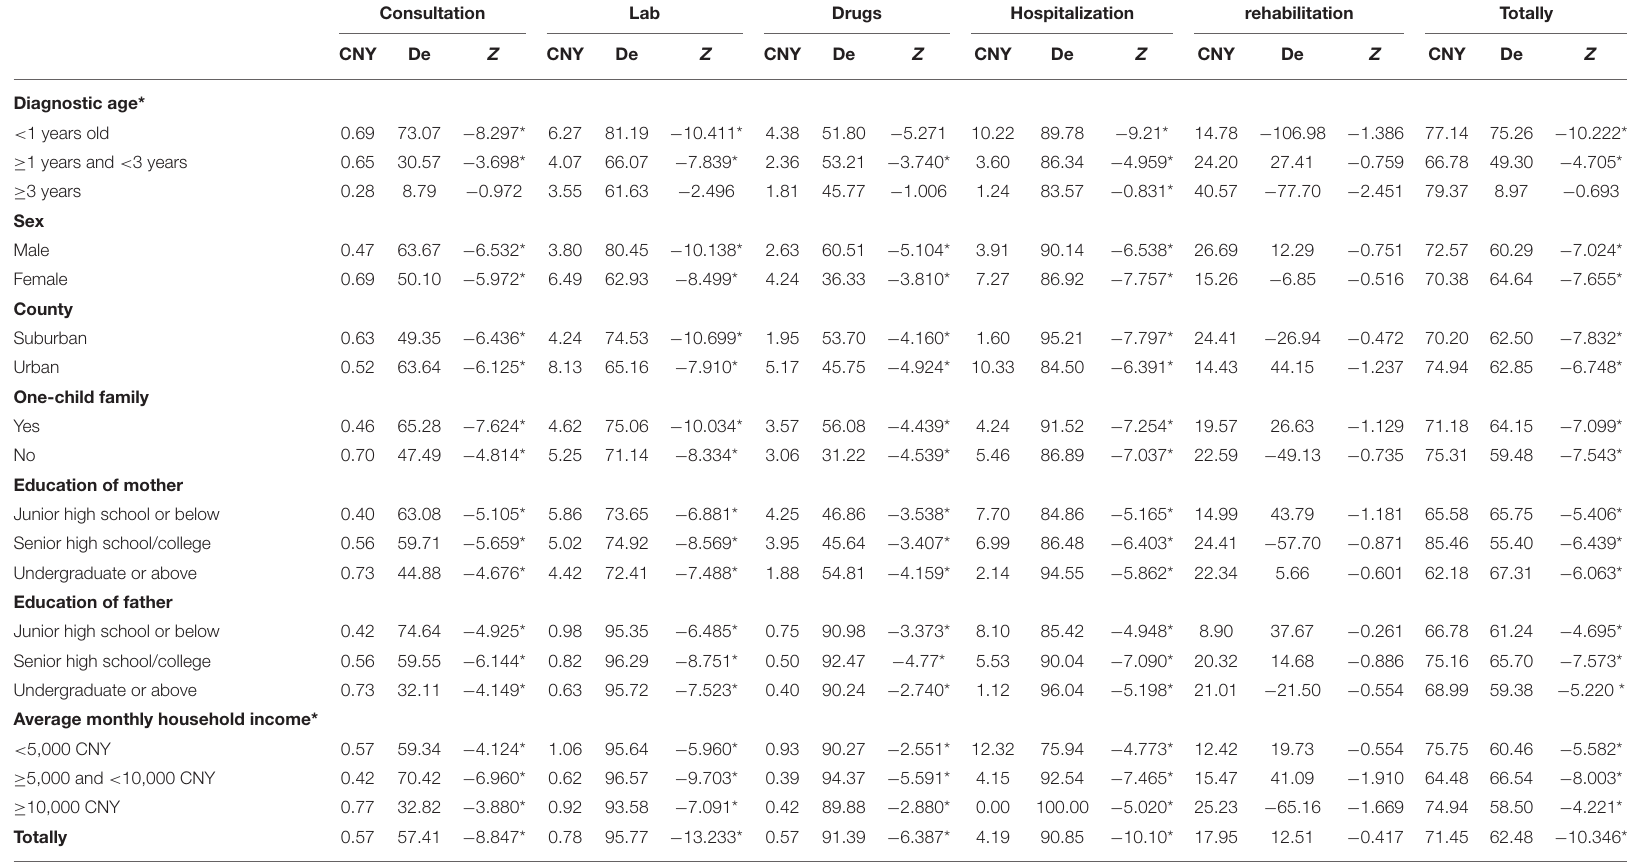
TABLE 4 | Comparison of direct medical cost per day per patient after the GD than before (CNY). Consultation Lab Drugs Hospitalization rehabilitation